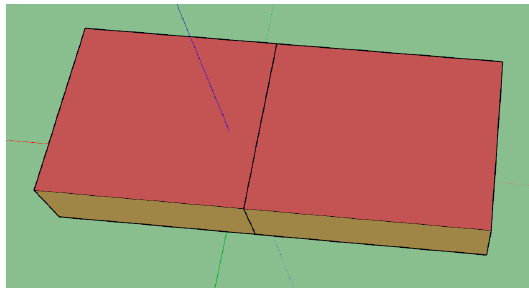
Figure 10. The 3D model from Scenario 3.